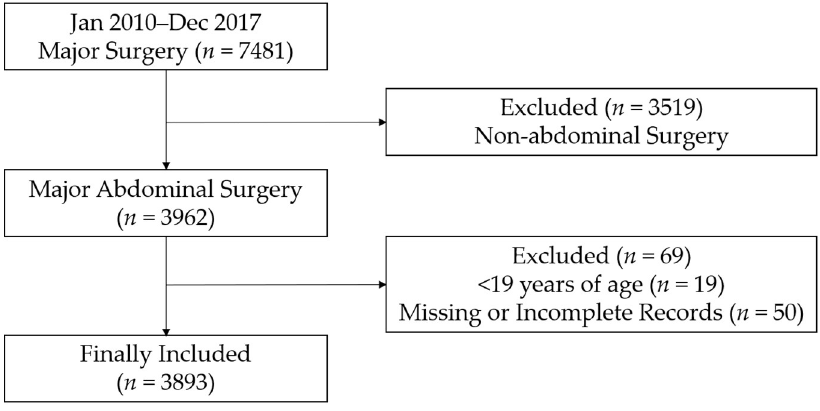
Figure 1. Flow chart for patient selection.